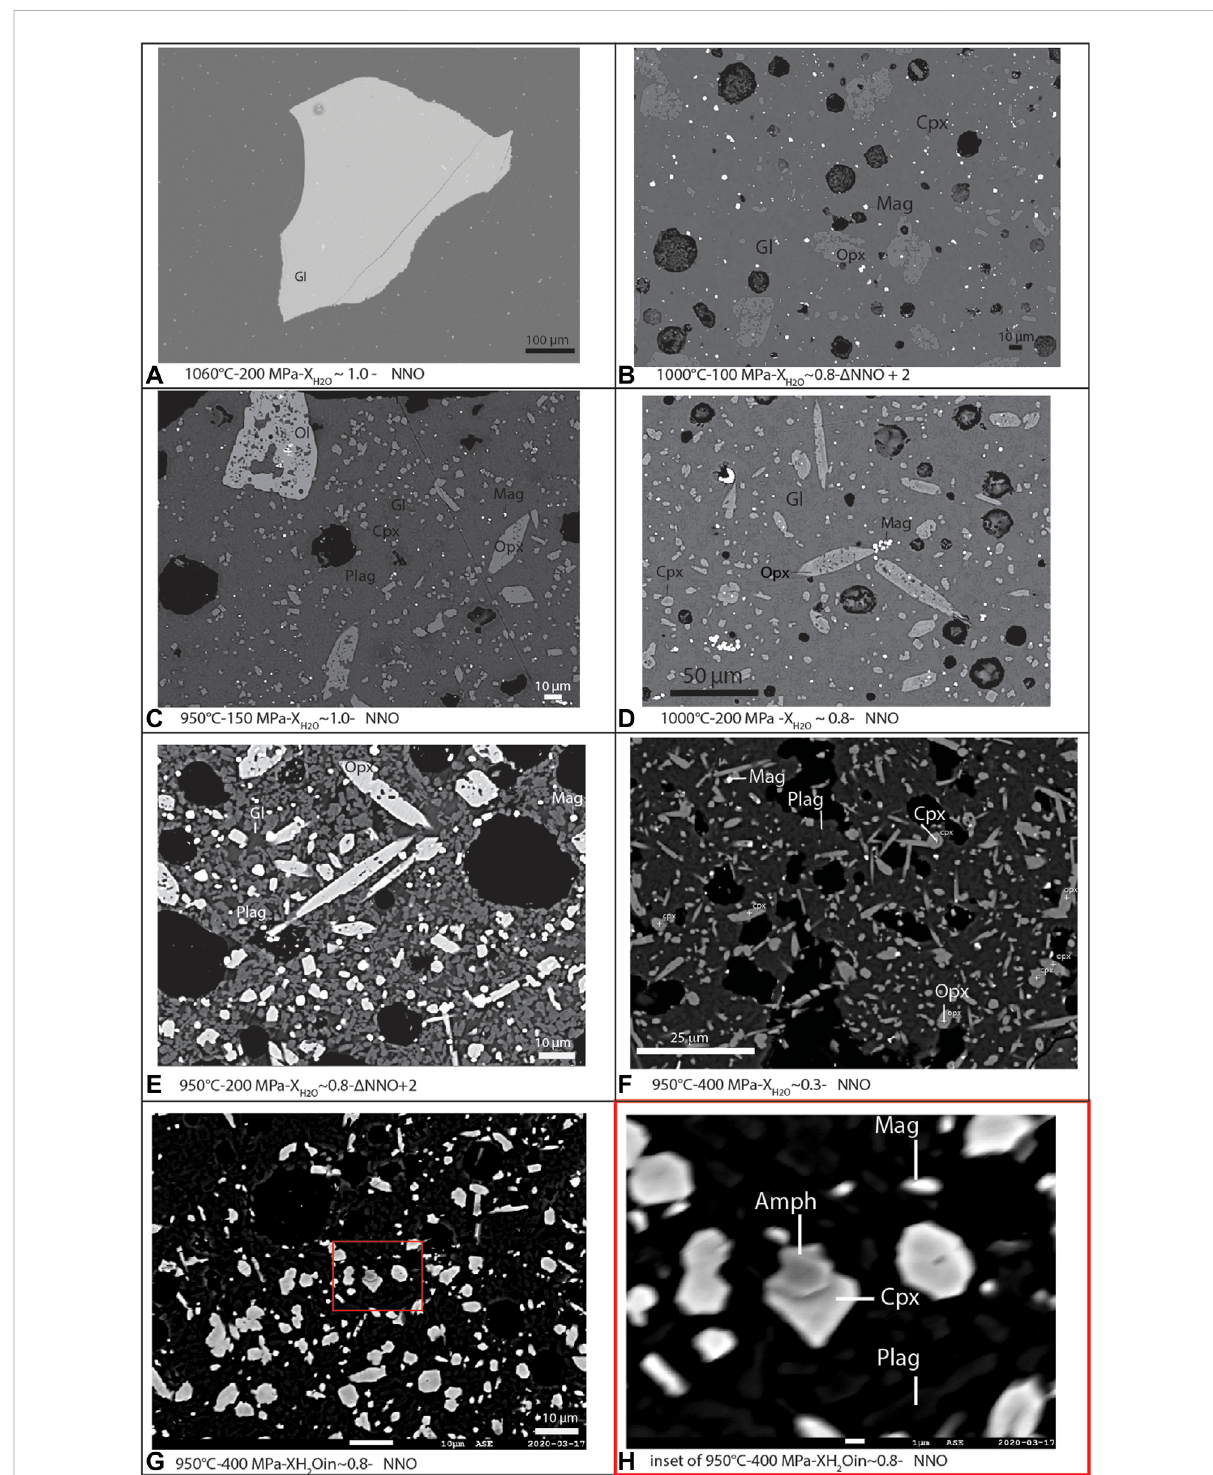
FIGURE 2 Annotated BSE images of selected representative experimental charges in order of increasing crystallinity. (A) 1,060 ° C-200 MPa-NNO. (B) 1,000 ° C-100 MPa- Δ NNO+2. (C) 950 ° C-150 MPa-NNO. (D) 1,000 ° C-200 MPa-NNO. (E) 950 ° C-200 MPa- Δ NNO+2. (F) 950 ° C-400 MPa-NNO. (G) 950 ° C-400 MPa-NNO. (H) Insetofchargein (G) Labeledwithabbreviatedmineralnames(Gl=glass,Plag=plagioclase,Cpx=clinopyroxene,Opx= orthopyroxene, Mag = magnetite, and Amph =